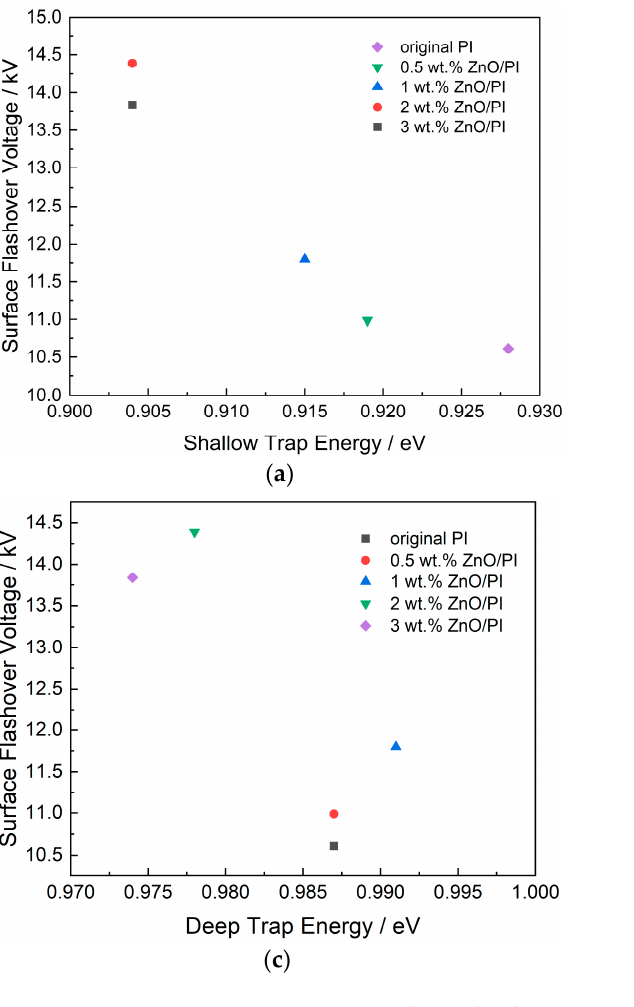
Figure 11. Relationship between surface trap distribution and surface flashover voltage. ( a ) Variation in flashover voltage with shallow trap energy; ( b ) variation in flashover voltage with shallow trap density; ( c ) Variation in flashover voltage with deep trap energy; ( d ) Variation in flashover voltage with deep trap density.